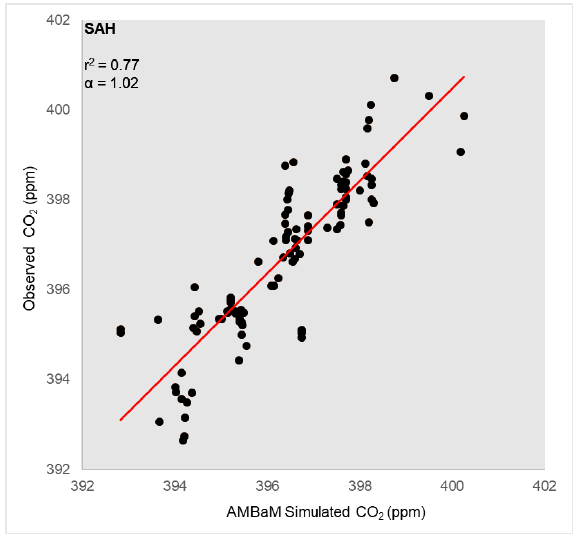
Figure 1. Correlation between CO 2 background (BKG) predicted by Air-Mass Back-Trajectories Method (AMBaM) and CO 2 samples profiles above 4 km altitude taken at